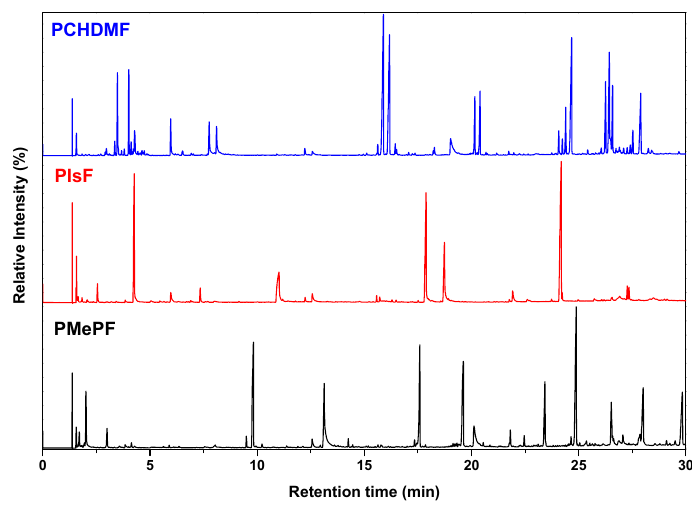
Figure 13. Gas chromatographs of the polyesters after pyrolysis at 600 °C.